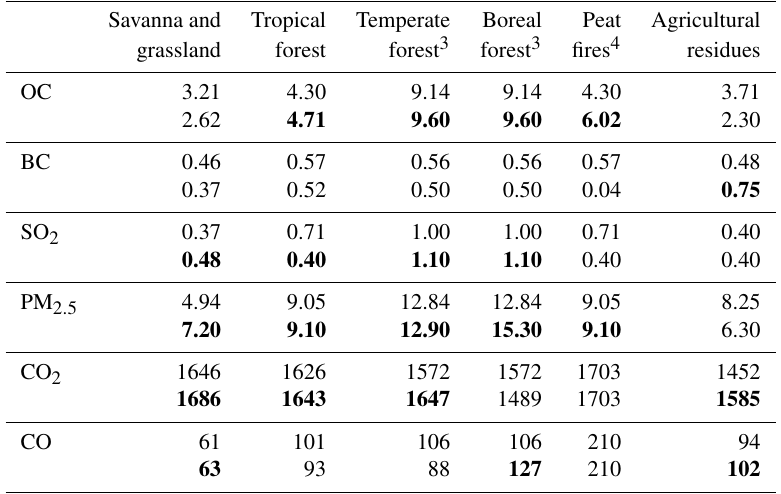
Table 2. Comparison of emission factor (units: gspecieskg − 1 dry matter burned) used by GFED3.1 1 and GFED4s 2 (listed in the upper and lower parts of the cell, respectively, and bold if GFED4s is